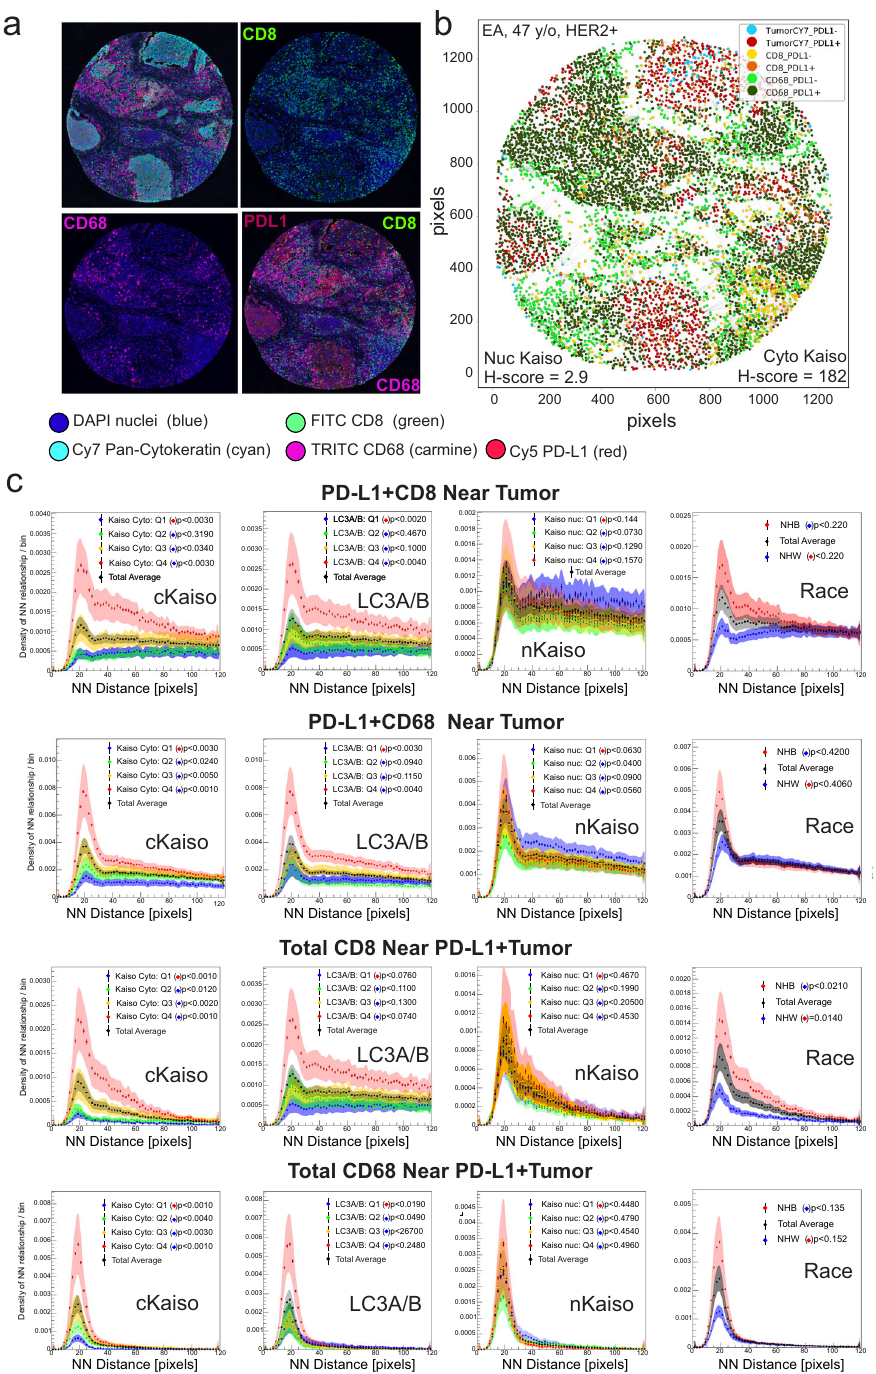
Fig. 7 Elevated cytoplasmic Kaiso, LC3A/B, and race are associated with an immune-suppressive tumor microenvironment. a Representative multi- spectral quantitative immuno fl uorescence (mQIF) of the tumor microenvironment of a breast cancer TMA core, stained for pan-cytokeratin (Cy7, cyan); PDL-1 (Cy5, red); CD8 (FITC, green); CD68 (TRITC, carmine). b Coordinate map for nearest-neighbor analysis of tumor and stromal immunophenotypes. c Nearest-neighbor analysis showing the frequency distribution of immune cell proximities to tumor-associated with expression quartiles (Q1 – Q4) of cytoplasmic Kaiso, LC3A/B, nuclear Kaiso, and race (white versus black). MB-231 and MCF-7 used in this study were obtained from ATCC and identify was were then stained with mouse anti-Kaiso (Abcam, ab12723; 1:1000) and rabbit validated by STRS pro fi ling. All cells were tested and found to be free of myco- anti-LC3A/B (Abcam, ab128025; 1:1000) in antibody diluent (PBS, 0.1% Tween-20, bacterial contamination. 1% BSA) for 1 h at RT in a humidi fi ed chamber. Anti-LC3A/B antibody recognizes both LC3A and LC3B proteins. After appropriate PBS washing, cells were stained with anti-mouse Alexa Fluor 488 (Invitrogen, A-11001; 1:2000) and anti-rabbit Colocalization analysis . Z -stack images for each channel were captured at ×100 Alexa Fluor 594 (Invitrogen, A-11002; 1:1000) secondary antibodies in a humidity magni fi cation with Immersol 518F (Zeiss) oil immersion using a Zeiss Axiovert chamber in the dark for 1h at RT. Coverslips were washed and then mounted on 200M fl uorescent microscope running AxioVision software. Slices with the clearest slides using ProLong Gold antifade reagent (Molecular Probes, P36934). MDA- COMMUNICATIONS BIOLOGY| (2021) 4:150